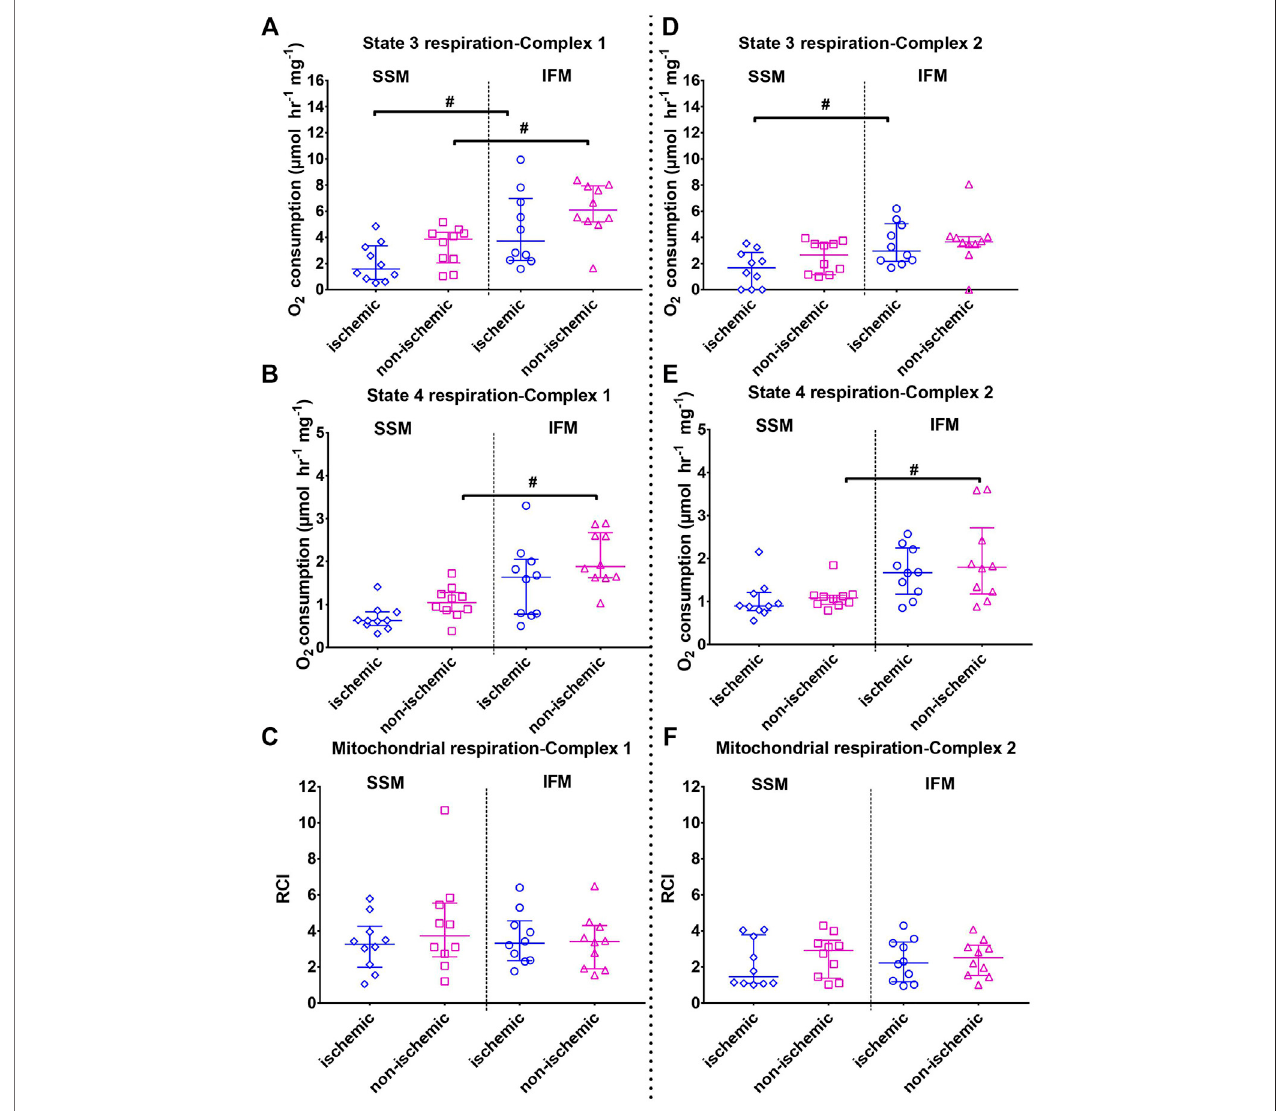
FIGURE 3 | Mitochondrial state 3 (top) and state 4 (middle) oxygen consumptions and the respiratory control indices (RCI, state 3/state 4, bottom panels). Left panels (A – C) indicates outcomes (state 3, state 4 and RCI, respectively) using mitochondrial complex I substrates (pyruvate + malate); right panel B (D – F) indicates outcomes (state 3, state 4 and RCI, respectively) using mitochondrial complex II substrate (succinate + rotenone). Values are represented as median with interquartile range ( n = 7 – 10/group). # indicates p ≤ 0.05 (two-tailed) compared to SSM. For exact p -values of all group comparisons, please refer to Table 2 .